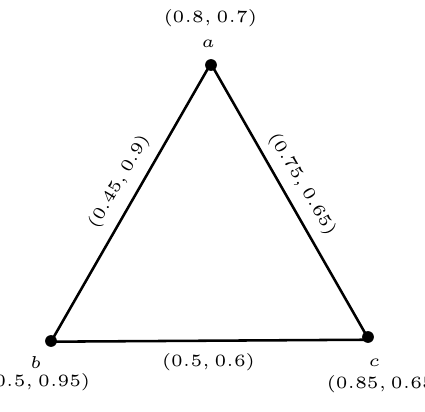
Figure 3.1: A 3-rung orthopair fuzzy graph G Figure 3. A 3-rung orthopair fuzzy graph G